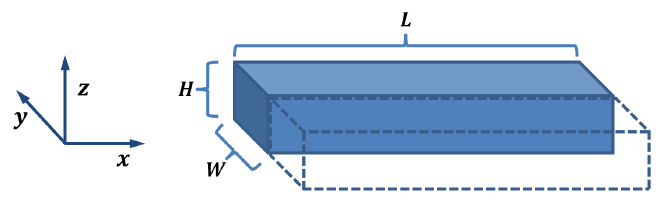
Figure 3. The schematical drawing of the 3D-printed traxels present in the model, with length L , width W , and height H . The cross section is drawn as a rectangular shape to clearly indicate the main dimensions; however, the actual cross section looks more like a trapezoid with rounded corners, like in Figure 2b.